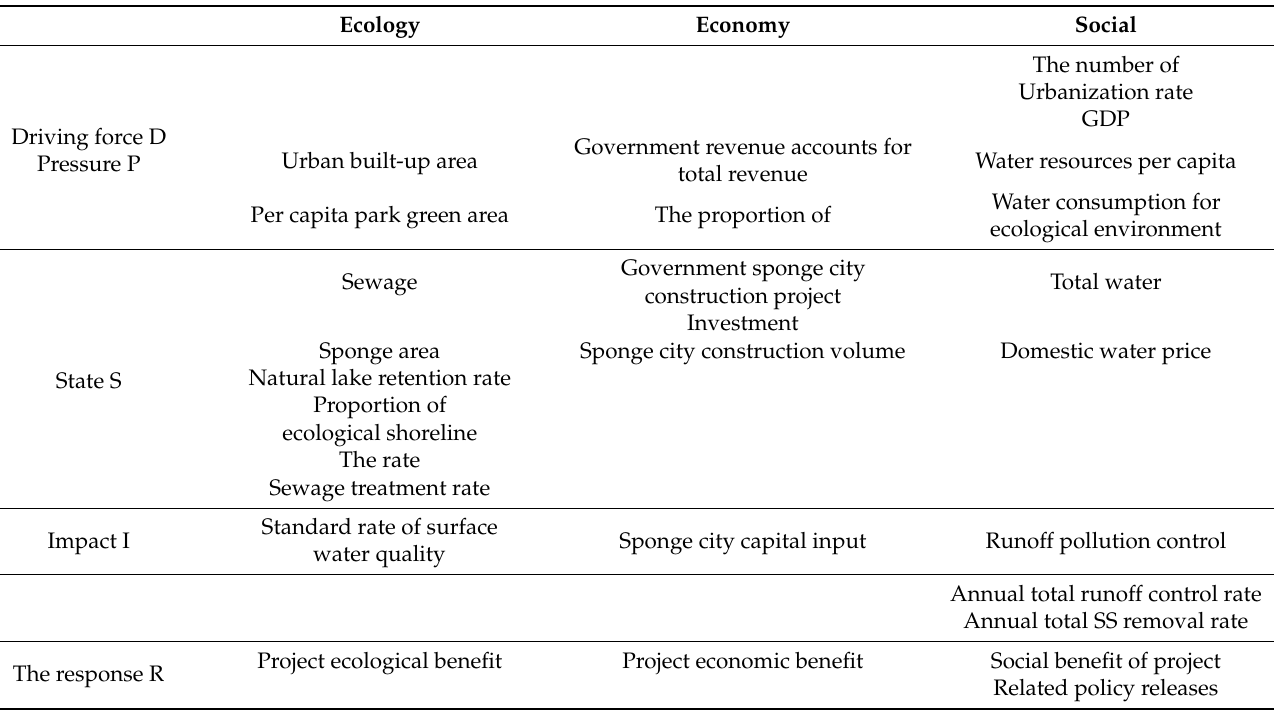
Table 1. Sponge city construction performance evaluation system based on DPSIR-EES